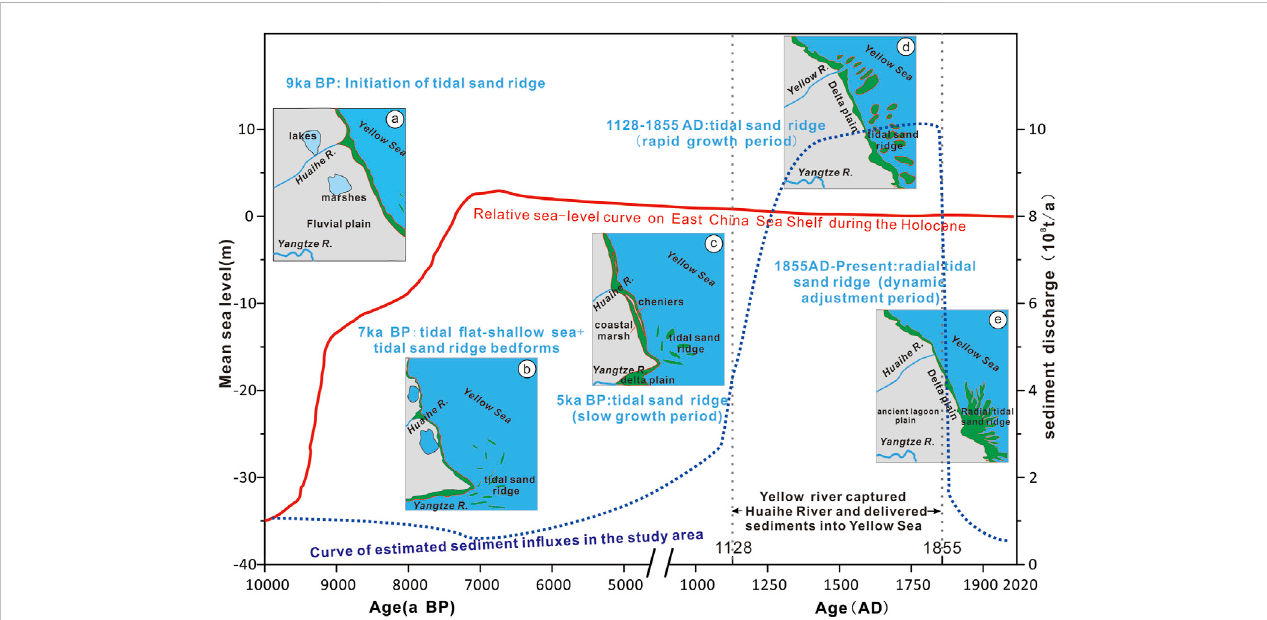
FIGURE 12 Synoptic geomorphological diagram revealing the relationships between Holocene evolution of the tidal sand ridge and relative sea-level change and sedimentsupplyinthesouthYellowSea.Therelativesea-levelcurveontheEastChinaSeashelfismodi fi edfromXue(2014).Thecurveofestimatedsediment in fl uxes in the study area is referred to as the estimated sediment discharge of the Yellow River by Wang et al. (2007a). (A) 9 ka BP: initiation of tidal sand ridge bedforms during the rapid sea-level rise at the early Holocene; (B) 7 ka BP: the tidal fl at and shallow sea environments well developed in the study area during the Holocene maximum transgressive period. The tidal sand ridge may mostly occur outside the Yangtze River mouth according to Li et al. (2001); (C) 5 kaBP:thetidalsandridgedevelopedslowlyinthesouthYellowSea,whilethecheniersandcoastalmarshesarewelldevelopedinthecoastalarea(Wangand Ke,1989); (D) 1128 – 1855AD:rapidgrowthofthetidalsandridgeaftertheYellowRivercapturingtheHuaiheRiverandsubsequentlydeliveringalargeamount of sediment into the study area; and (E) 1855 AD – present: dynamic adjustment of the radial tidal sand ridge after the Yellow River emptying back into the Bohai